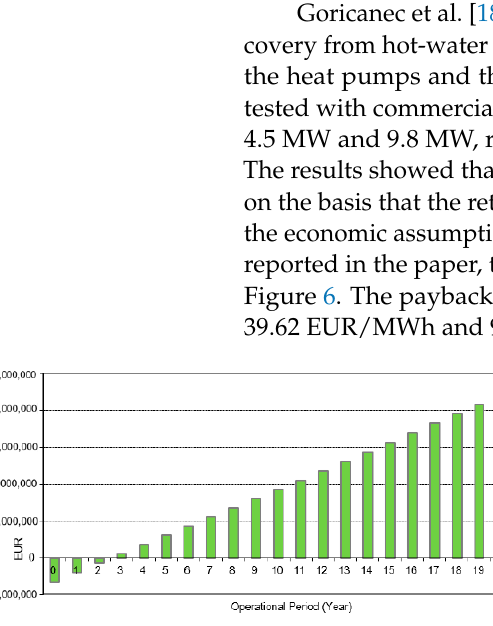
Figure 6. Cumulative discounted cash flow at electricity prices of 92.2 EUR/MWh ( left ) and 39.62 EUR/MWh ( right ).